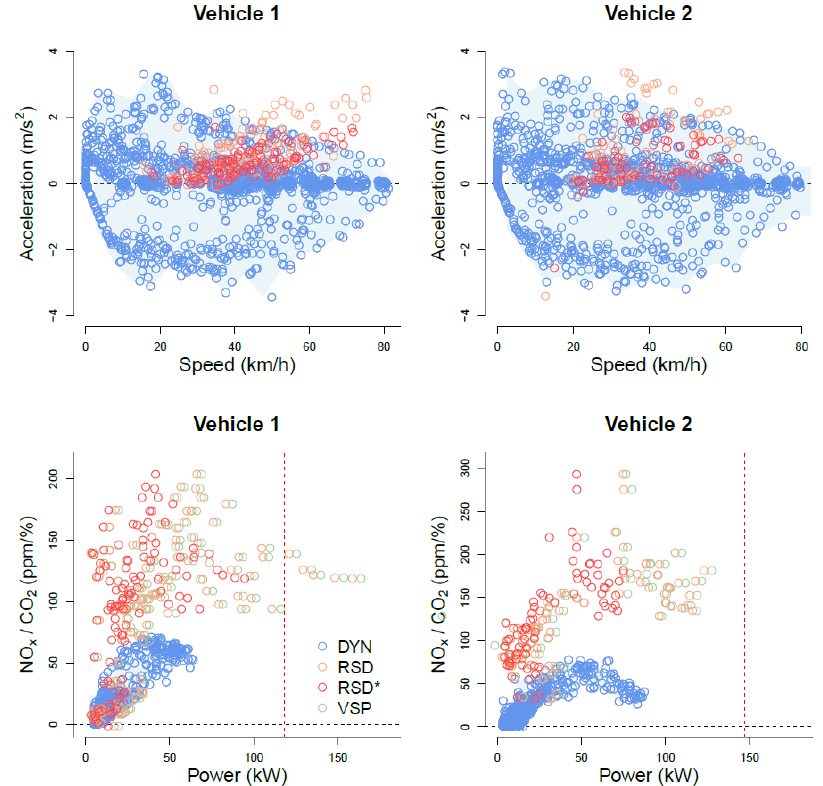
Figure 9. Dynamometer and RSD speed, power and hot running emissions data (rated engine power is dashed red line).